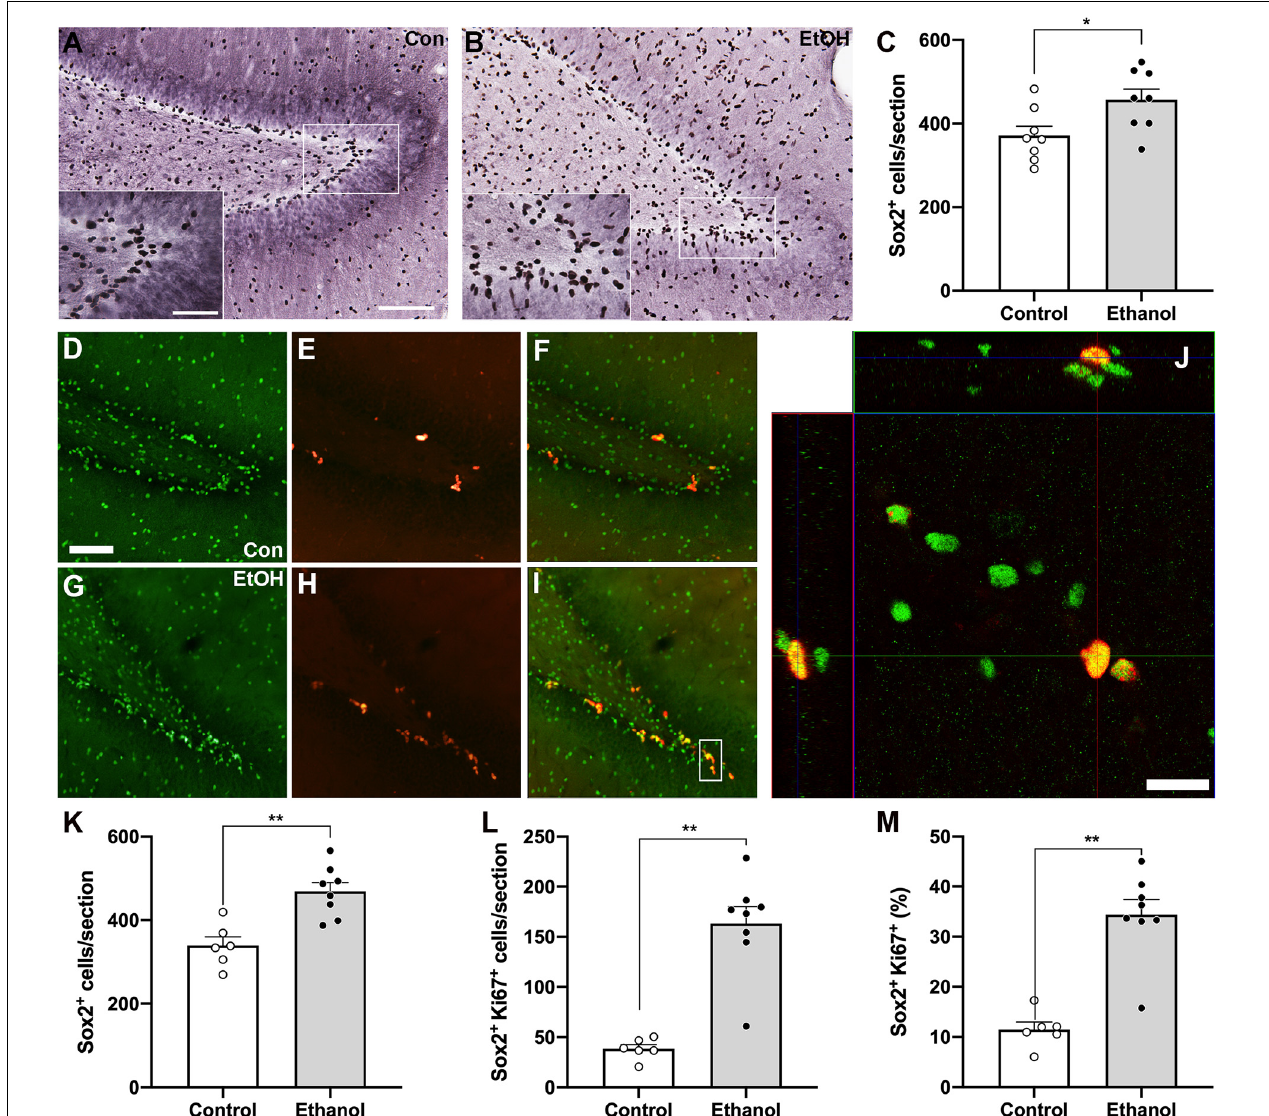
FIGURE 3 | Alcohol-induced reactive neurogenesis is a result of an increase in active division of NPC. Representative images of Sox2+ cells in the hippocampus of a control [ (A) n = 8] and ethanol-treated [ (B) n = 8] rat at T7 as quantified in panel (C) . Representative images of Sox2+ (D,G) , Ki67+ (E,H) , and dual-labeled cells (F,I) in a control (D–F) , n = 6) and an ethanol-treated [ (G–I) n = 8] rat following 7 days of abstinence. (J) 3-D rendered z-stack images “orthogonal view” to show Sox2+/Ki67+ co-labeling in the same cell. (K) The increase in Sox2 expression was replicated with immunofluorescence. Additionally, all Sox2+ cells were assessed for the presence of Ki67 expression. As previously observed in males, there was a significant increase in the amount (L) and proportion (M) of actively dividing NPC in ethanol-treated rats compared to controls at T7. (M) Data are mean ± SEM. Symbols represent individual data points. Scale bars = 100 µ m in A main, D; 50 µ m A inset; 20 µ m in panel (J) . * p < 0.05; ** p <